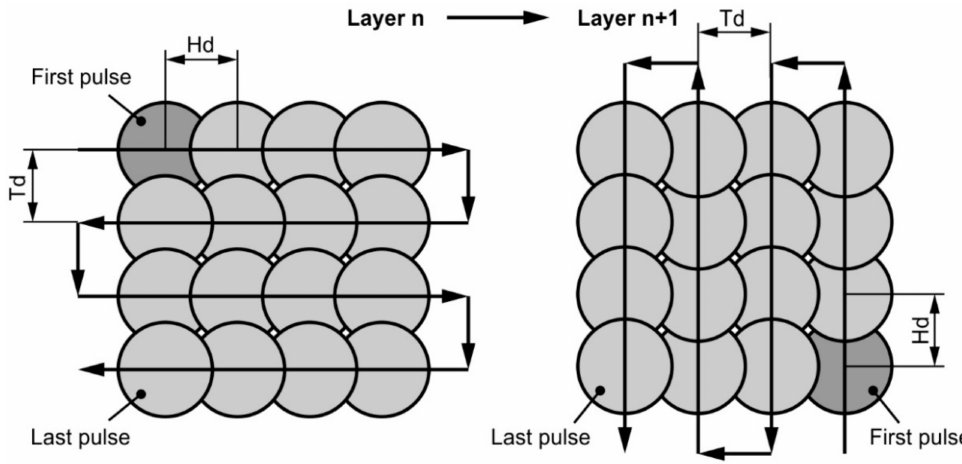
where: Hd is the hatching distance; V is the scanning speed; F is the repetition rate; Td is the track distance.